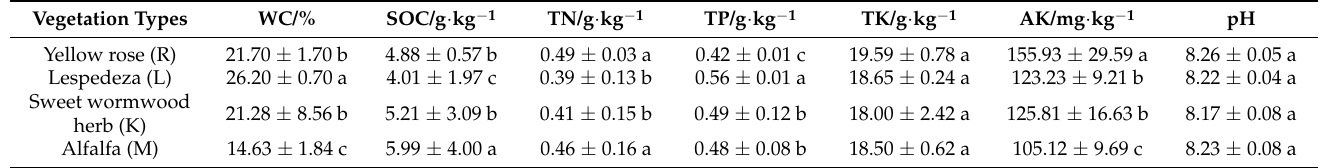
Table 1. Chemical properties of reclaimed soils with different plant types.